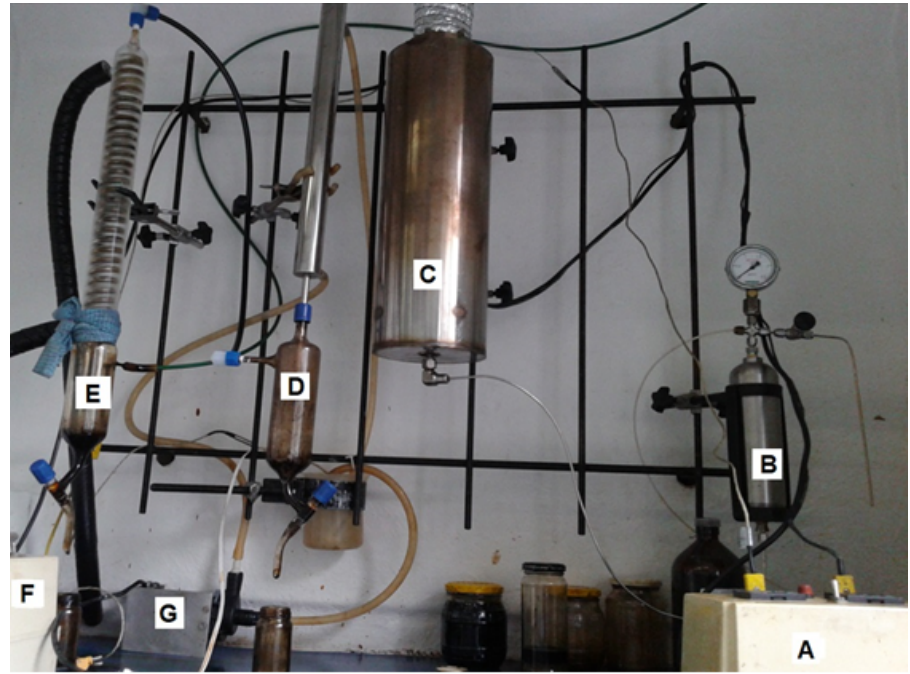
Figure 1. Pyrolysis system: ( A ) Heat or temperature controller; ( B ) Pressure maintainer; ( C ) Main electric furnace (biomass); ( D ) Condenser with 100 ◦ C; ( E ) Condenser with 5 ◦ C; ( F ) Cooler; ( G ) Hot water